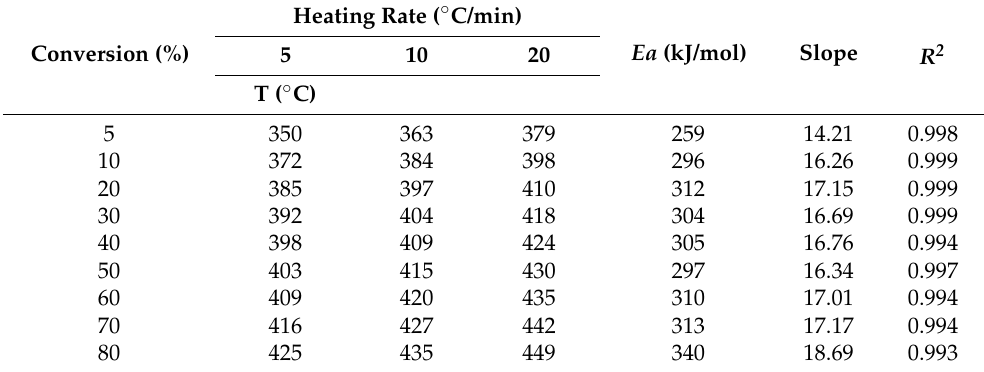
Figure 7. TGA thermal degradation analysis results of the PBT–EVOH polymer composite film using 1.5% triallylamine crosslinking agent. Table 3. The corresponding thermal analysis results of the 1.5%-triallylamine-crosslinking PBT– EVOH polymer composite